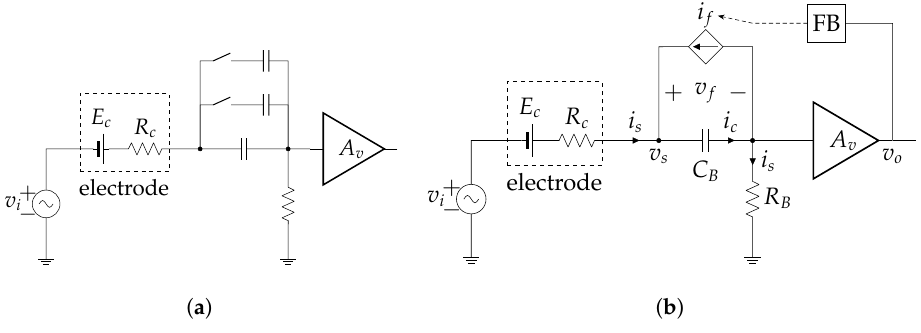
Figure 1. Simple ( a ) and proposed ( b ) amplifier topology for obtaining a variable bandwidth. The